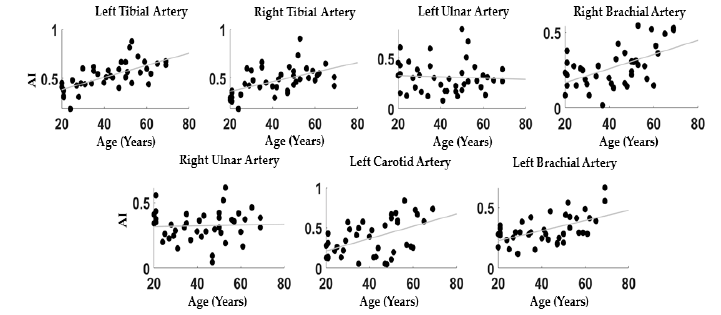
Figure 2. Scatter plots between age and AI for all the measurement